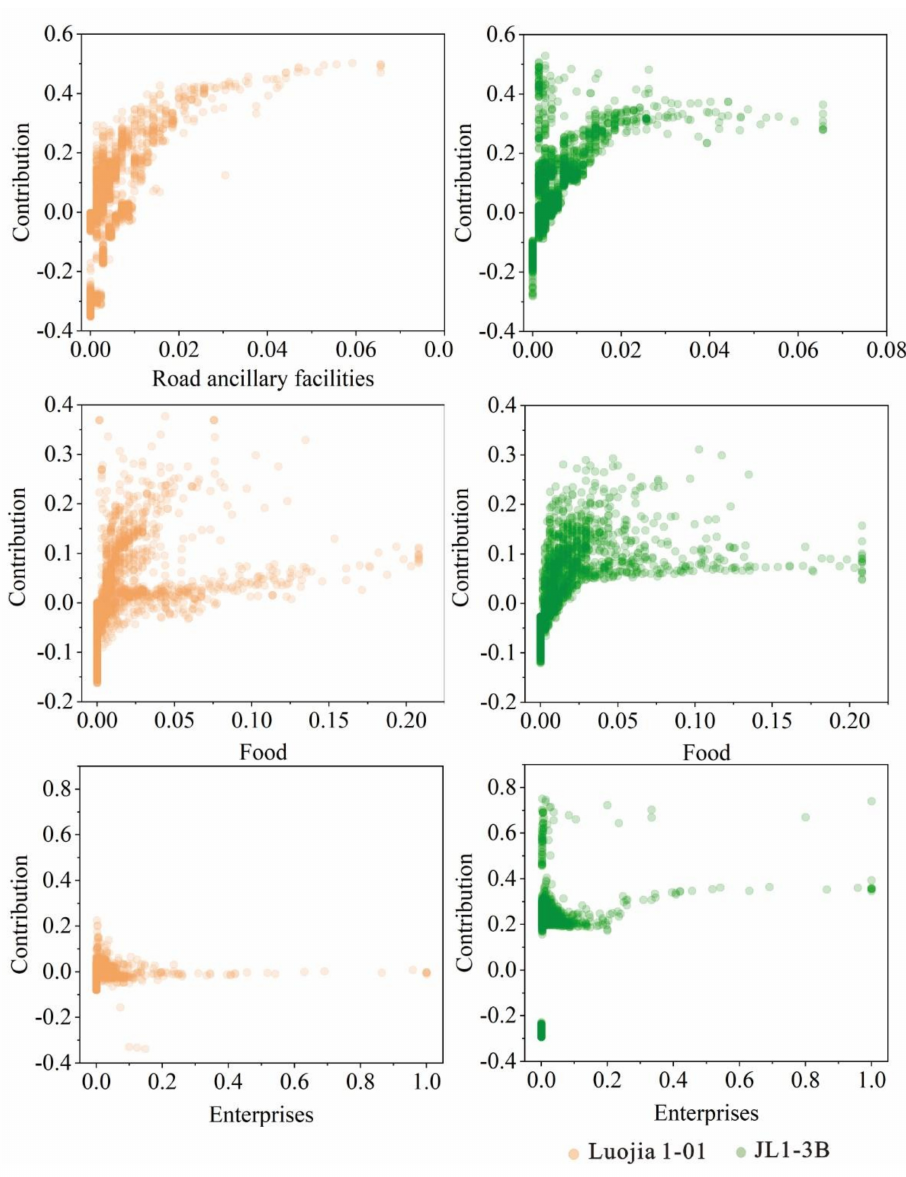
Figure 9. The features contributions of road ancillary facilities, enterprises, and food in the RF models for Luojia1-01 and